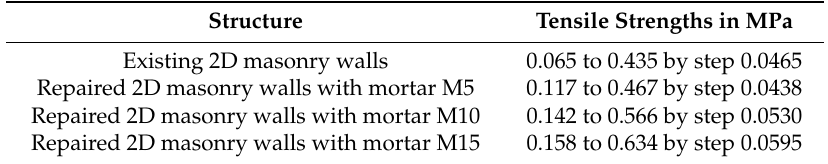
Table 10. Values of tensile strength (response parameter) of 2D masonry walls